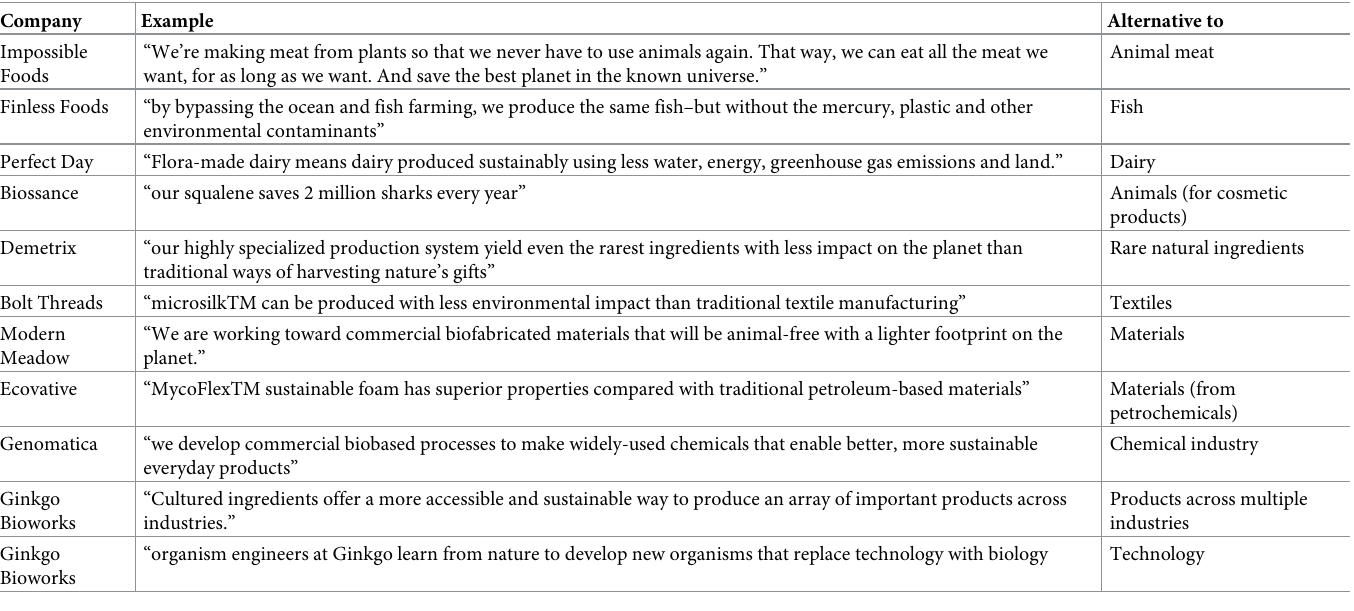
Table 2. Substitutive language used on company